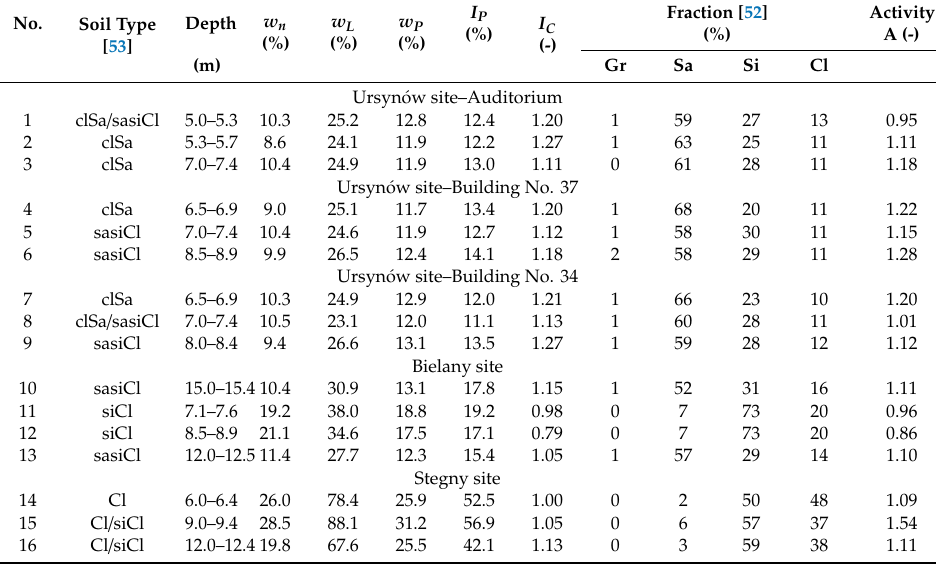
Table 2. Index properties of the tested cohesive